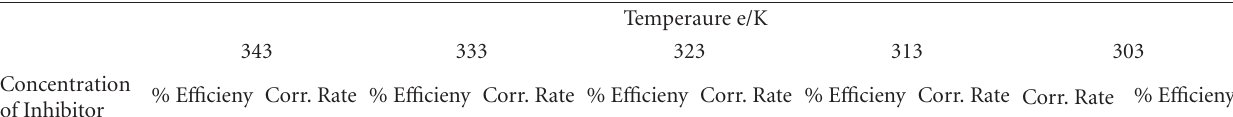
Table 3: The E ff ect of concentration of the aqueous extract of Neem leaves on the corrosion rate (mg · cm − 2 · h − 1 ) and percentage e ffi ciency of carbon steel in 1.0 M HCl at various temperatures.